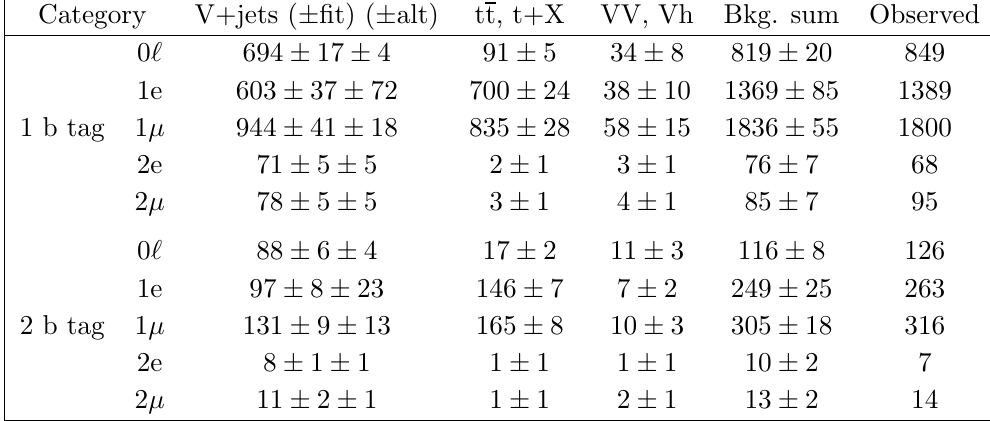
Table 2 . The expected and observed numbers of events in the signal regions depicted in (cid:12)gure 3 are reported for the di(cid:11)erent event categories, along with the associated uncertainties from four sources: the V+jets background uncertainty obtained from the correlated variation of the (cid:12)t parameters used in the background model ((cid:12)t); the uncertainty associated with the choice of (cid:12)t function, estimated by comparing the nominal and an alternative function (alt); the statistical component of the uncertainties of the top quark scale factors, and the extrapolation uncertainty from the control regions to the SR; the VV normalization uncertainties relative to the normalization and m j modeling. A detailed description of the systematic uncertainties is provided in section